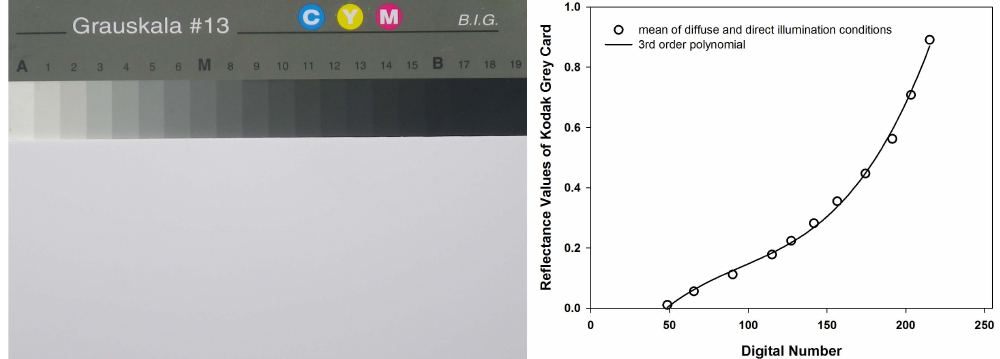
Fig. 5. Kodak gray card Q13 with the used reference board below (left panel). Relationship between the digital number derived from the gray card patches and the respective reflectance values (right